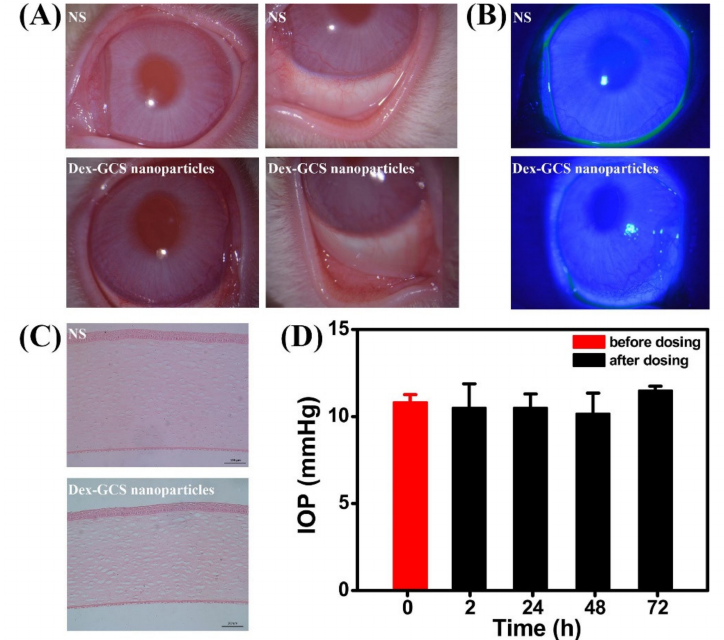
Figure 28. ( A ) Slit-lamp observations of the eyes treated with NS and DEX-GCS NPs at 2 h after administration; ( B ) fluorescein sodium staining of the cornea treated with NS and DEX-GCS NPs at 2 h after administration; ( C ) H&E section of the cornea treated with NS and DEX-GCS NPs at 24 h after administration; and ( D ) the changes in intraocular pressure (IOP) after treatment with Dex-GCS NPs [179]. Reproduced with permission from Elsevier